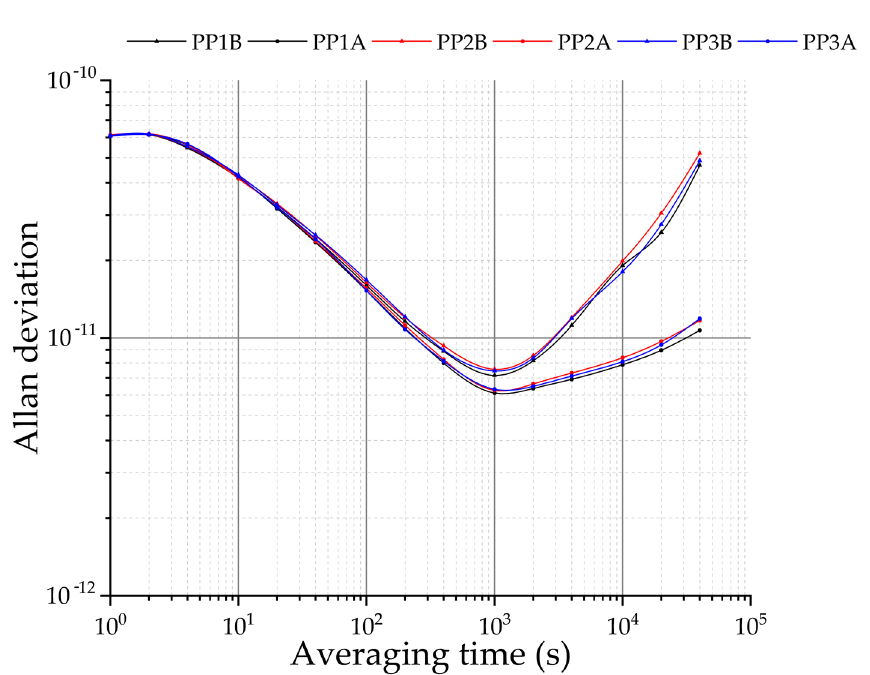
Figure 12. Frequency stability of the 3 different physics packages before and after vacuum packaging. PP1B: physics package 1 before vacuum packaging; PP1A: physics package 1 after vacuum packaging; PP2B: physics package 2 before vacuum packaging; PP2A: physics package 2 after vacuum packaging; PP3B: physics package 3 before vacuum packaging; PP3A: physics package 3 after vacuum packaging.